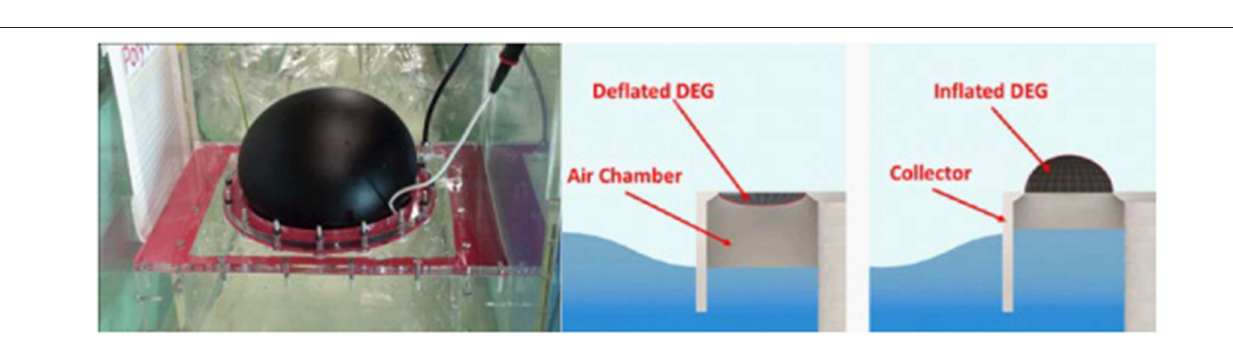
for testing in real sea conditions (SEAPOWERSRCL, 2017; Coiro et al., 2018,